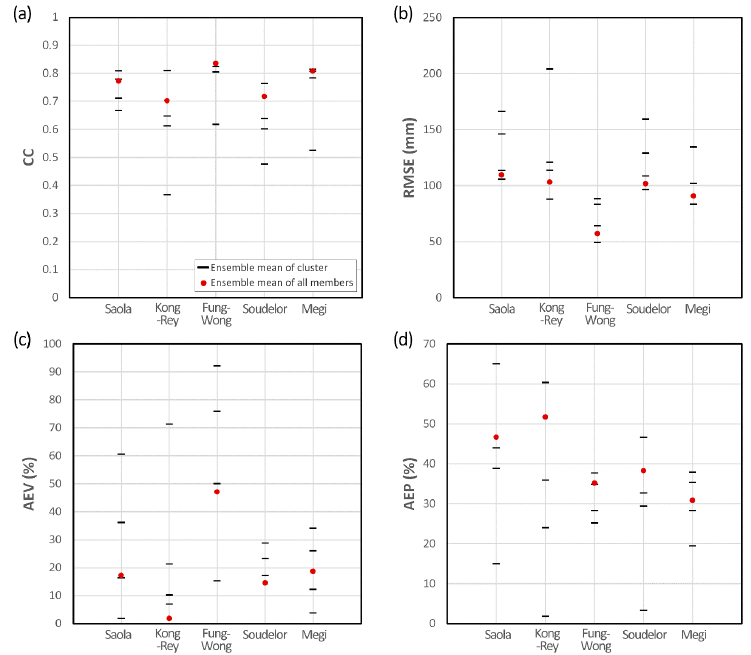
Figure 8. Performance measures of ensemble mean corresponding to each cluster and to all of the members, ( a ) CC ; ( b ) RMSE ; ( c ) AEV ; ( d ) AEP .